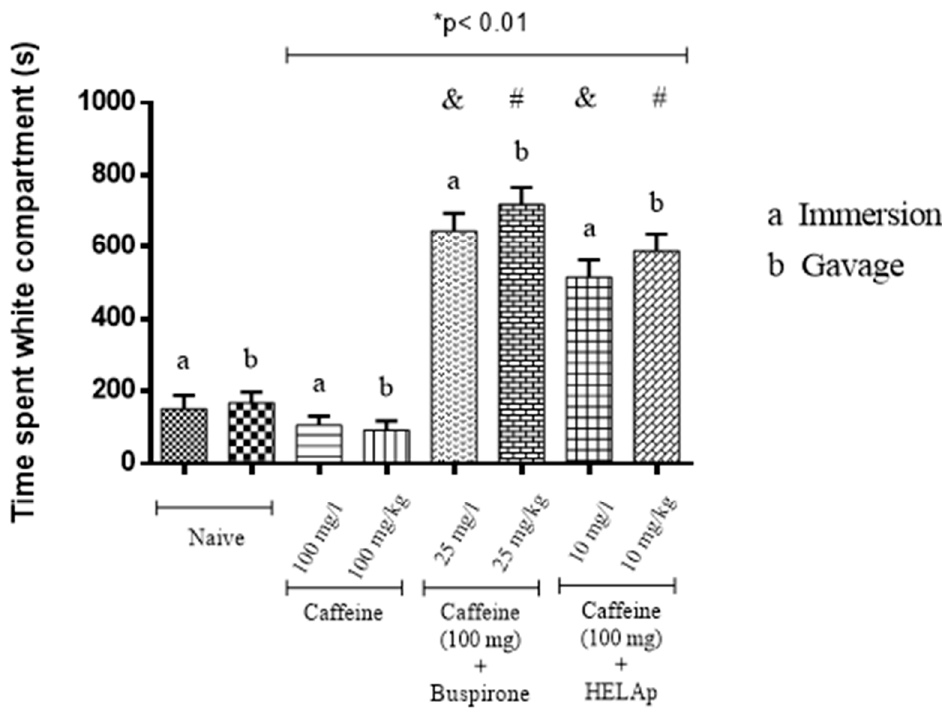
Figure 3. Effects of the hydroethanolic extract from A. polystachya , buspirone, and caffeine on zebrafish behavior in the scototaxis test (time spent in the white compartment) using immersion and oral (gavage) administration. Data are presented as a mean ± SEM (n = 4/groups); * p < 0.01 vs. naive fishes; & p < 0.01 vs. caffeine immersion; # p < 0.01 vs. oral caffeine administration. Statistical analysis was performed through one-way ANOVA followed by the post-hoc Tukey test.